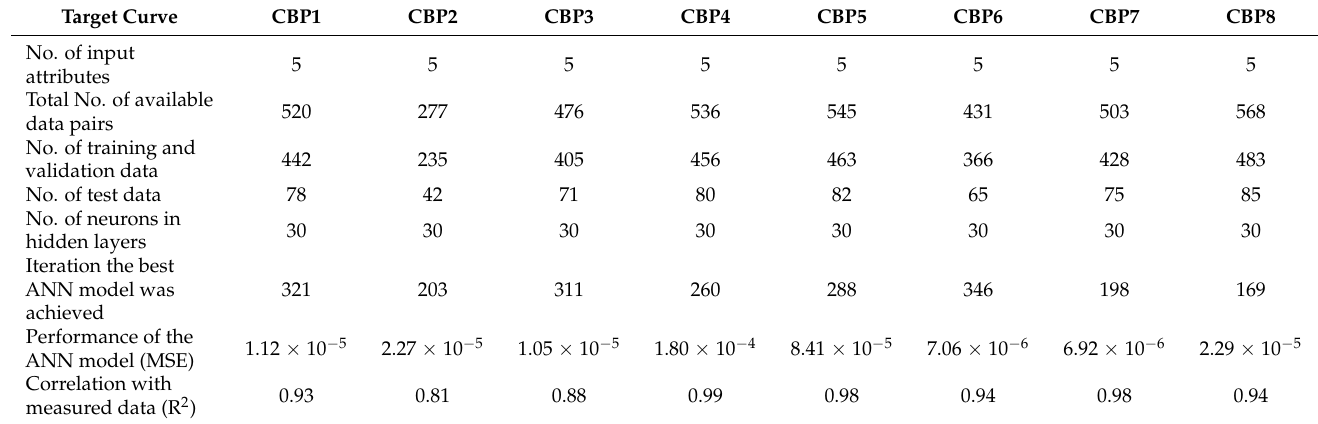
Table 4. Properties of the training data and performance of the intelligent models.